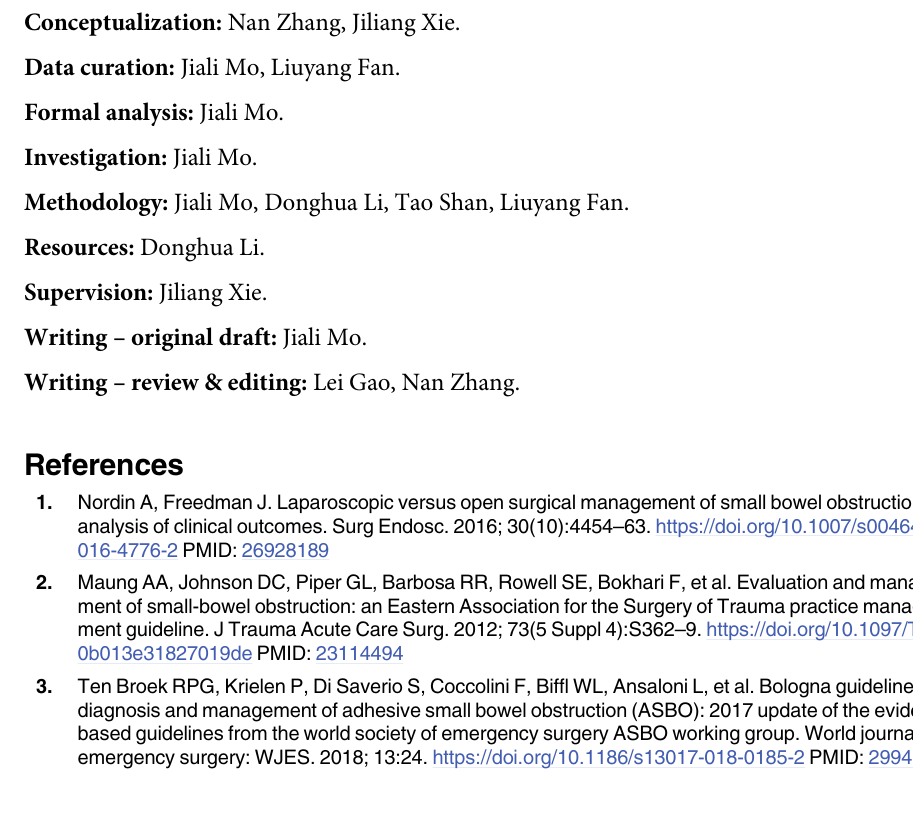
S1 Table. Count number of OTUs by taxonomic rank for each sample. S1 Dataset. Data of qPCR analysis of target bacterial groups. S2 Dataset. Data of ELISA results in the different experimental